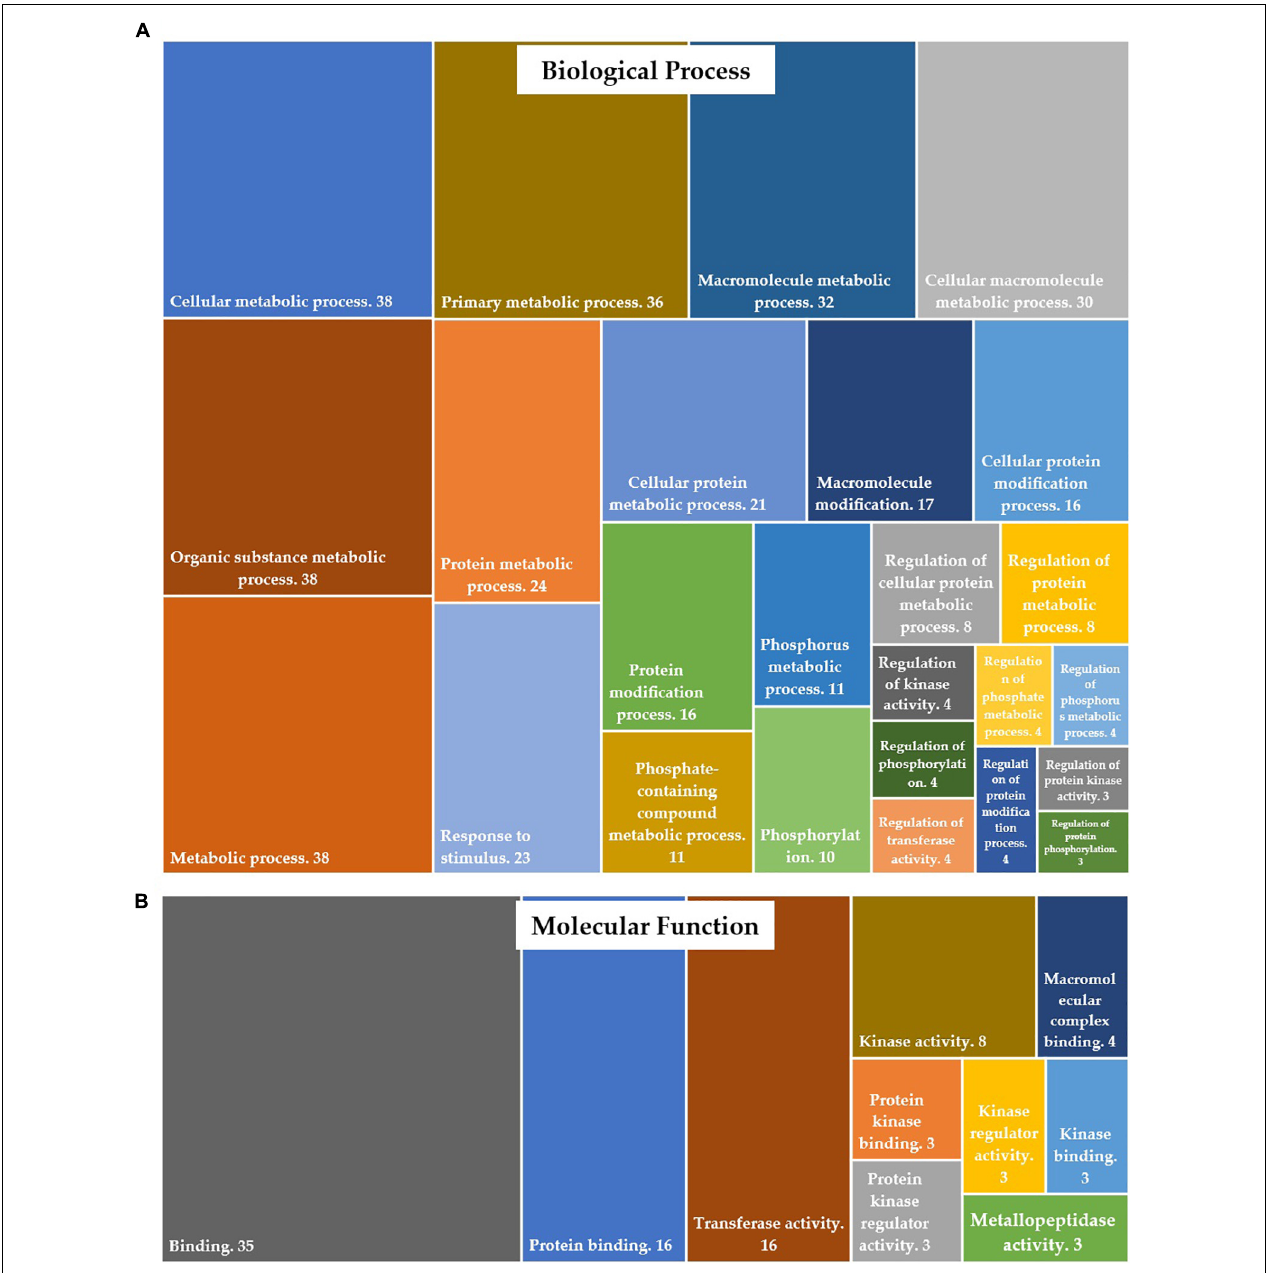
FIGURE 3 | Distribution of DEGs into gene ontology (GO) categories, according to (A) their involvement in biological processes and (B) their molecular